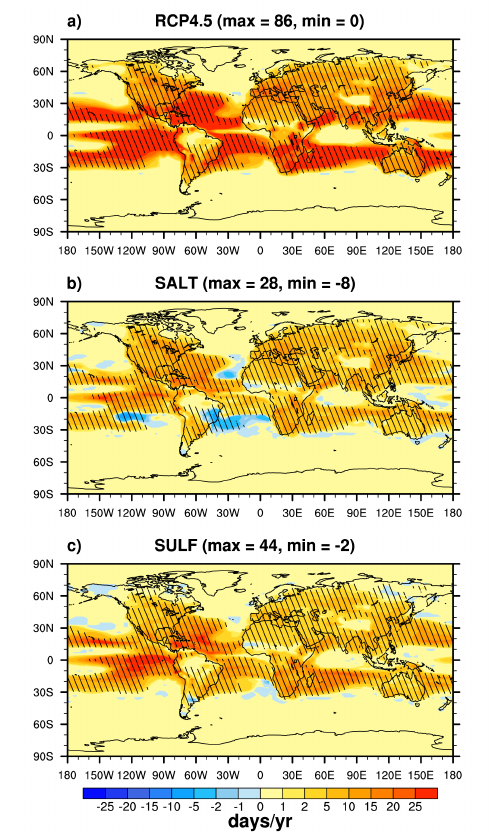
Figure 6. As Fig. 4, but for the mean change in summer